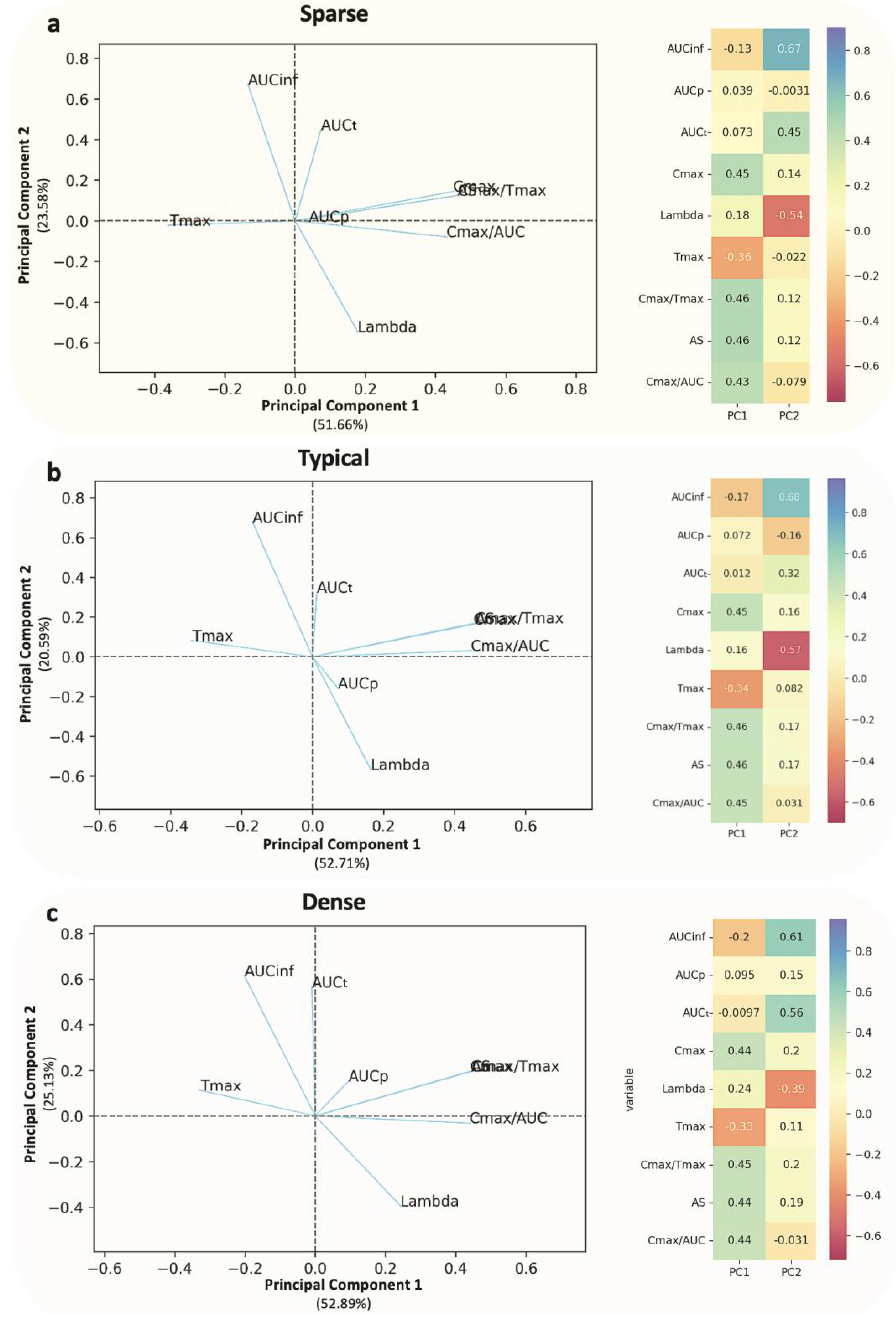
Figure 6. Principal component analysis for the pharmacokinetic parameters estimated from the simulated bioequivalence studies The results refer to the three simulated sampling schemes: ( a ) sparse, ( b ) typical, and ( c ) dense. Left panel: Biplot of the two principal components displaying the individual scores and the loadings (blue lines). Right panel: Loading values in the case of the first and second principal components (PC1 and PC2). A description of the pharmacokinetic parameters is provided in Table